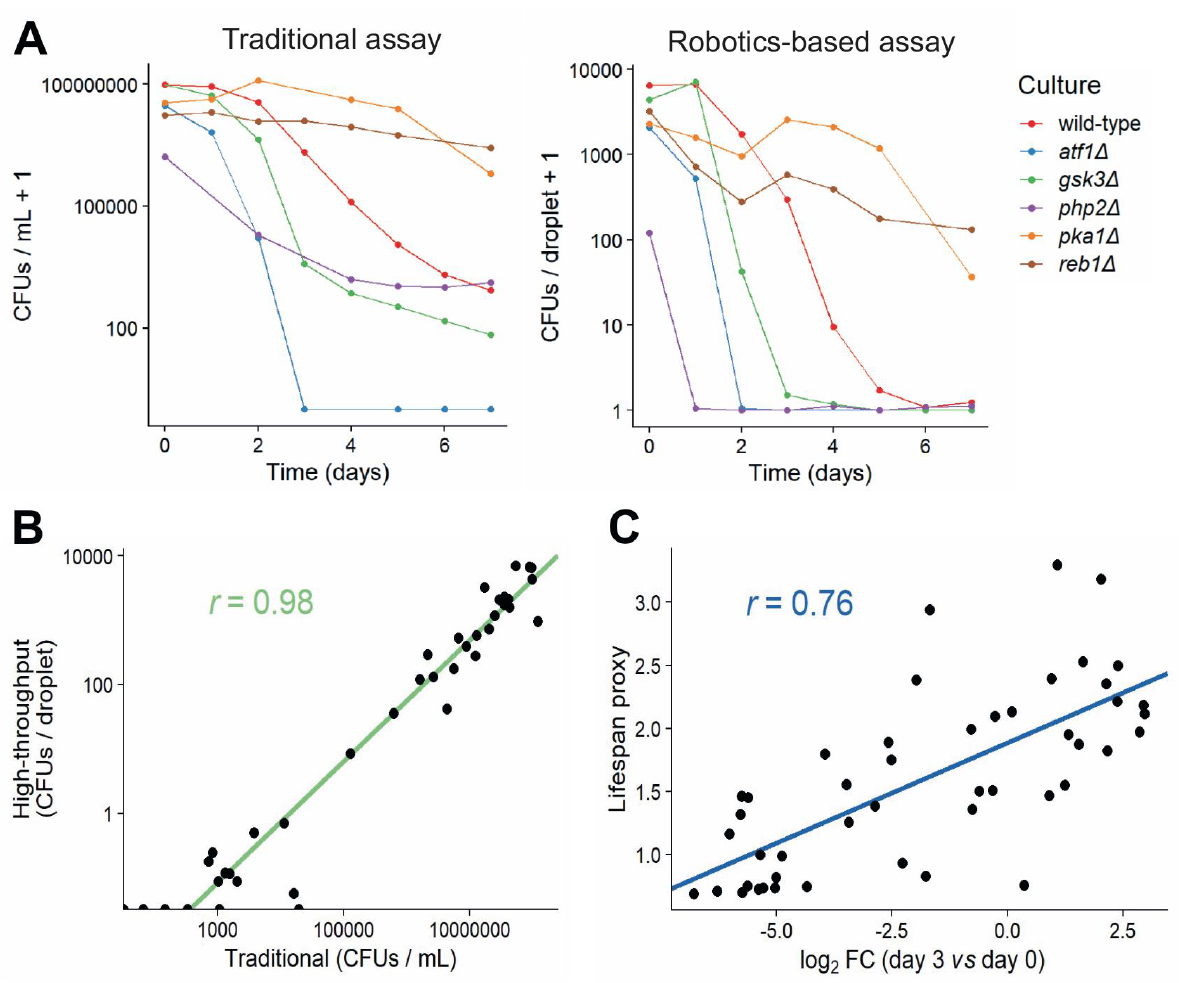
FIGURE 4: Comparison of traditional and high-throughput lifespan assays. (A) Comparison of traditional and robotics-based assays to de- termine CFUs. Lifespan curves for six mutants with different lifespans were measured in parallel using both the traditional (left) and robot- ics-based (right) assays. Both methods capture differences in lifespan between short-lived mutants ( atf1 Δ, gsk3 Δ , php2 Δ) and long -lived mutants ( pka1 Δ, reb1 Δ). (B) CFUs determined for various cultures (different mutants grown under different conditions) at different timepoints, using both the traditional and robotics-based method. Scatter plot shows the agreement between the two methods. Green: linear regression of log-transformed CFU values (traditional vs robotics-based), along with Pearson correlation coefficient. (C) Scatter plot showing the agreement of CLS estimates between Bar-seq and the robotics-based lifespan assay for the 47 validated mutants. The log 2 fold change (FC) of barcode abundance (Day 3 relative to Day 0) is plotted against the lifespan proxy based on maximum-likelihood estimates from the robotics-based method. Blue: linear regression between log 2 FC and lifespan proxy, along with Pearson correlation